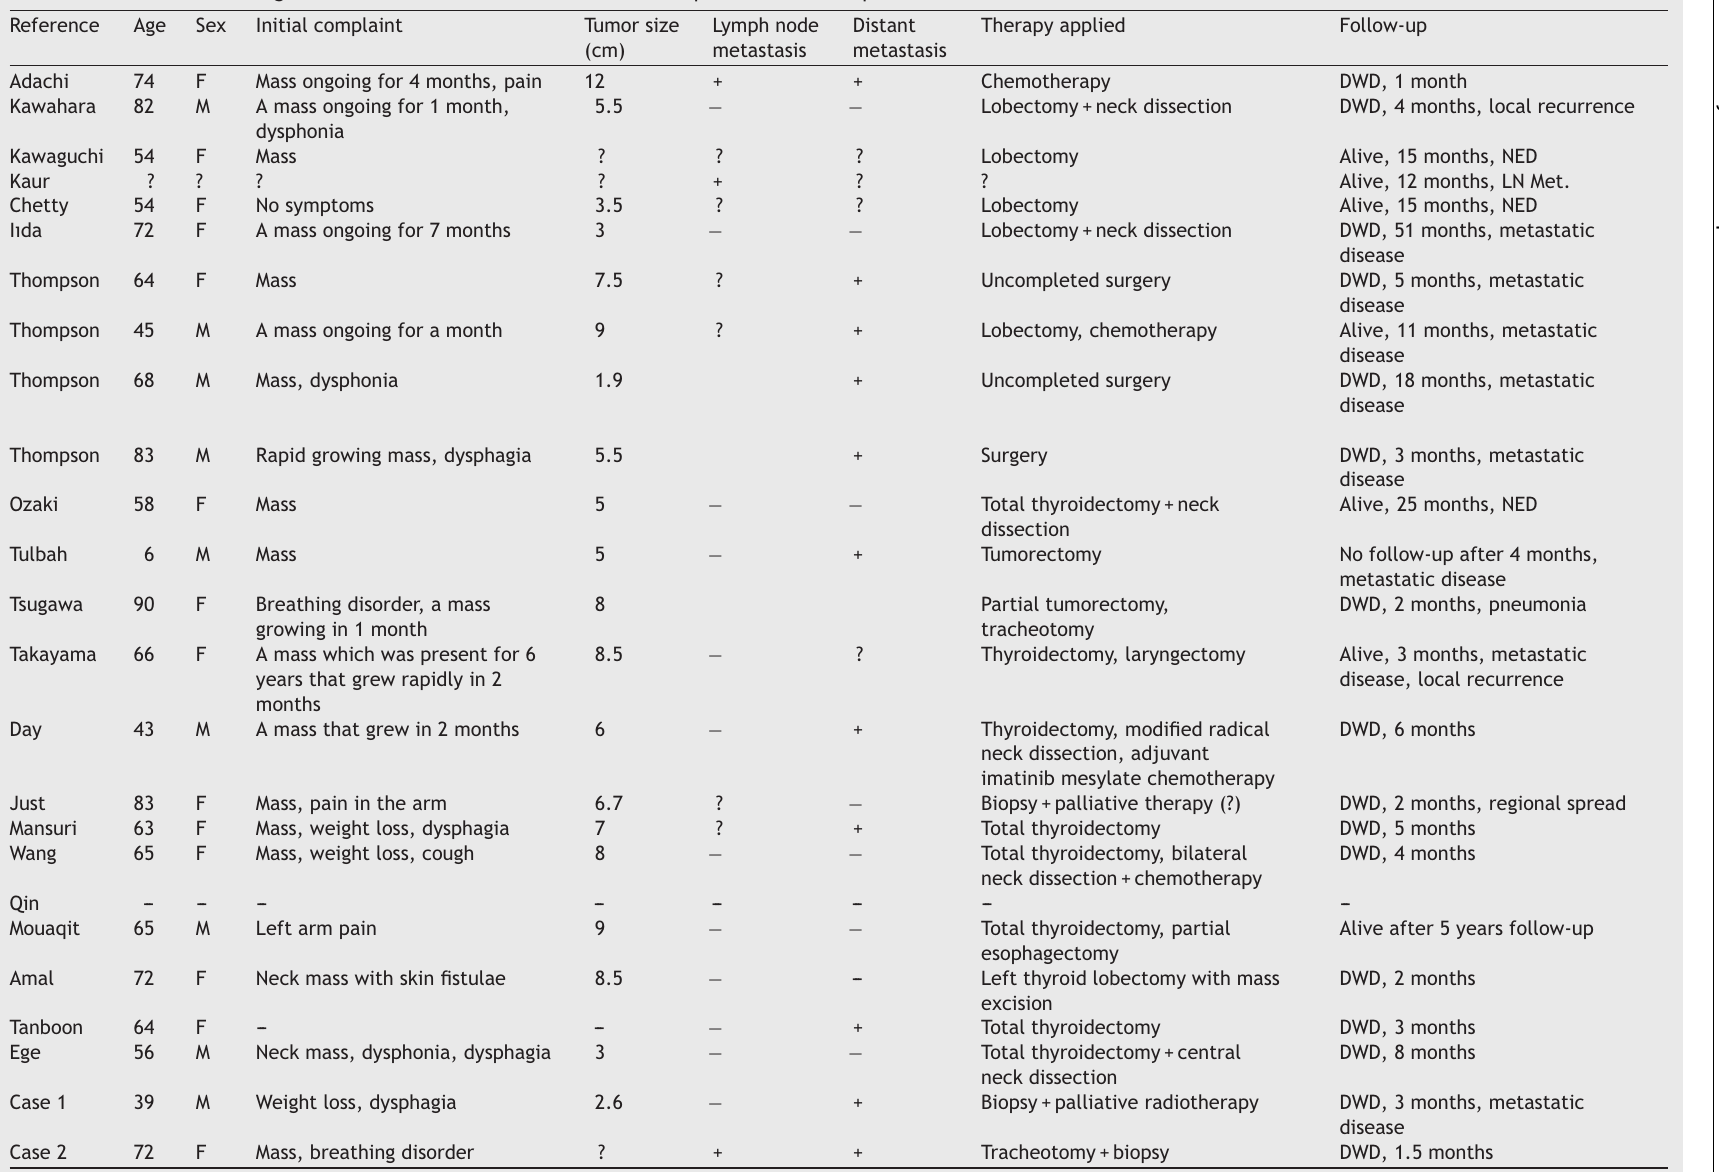
Table summarizing the 23 cases in the literature and the two patients in this